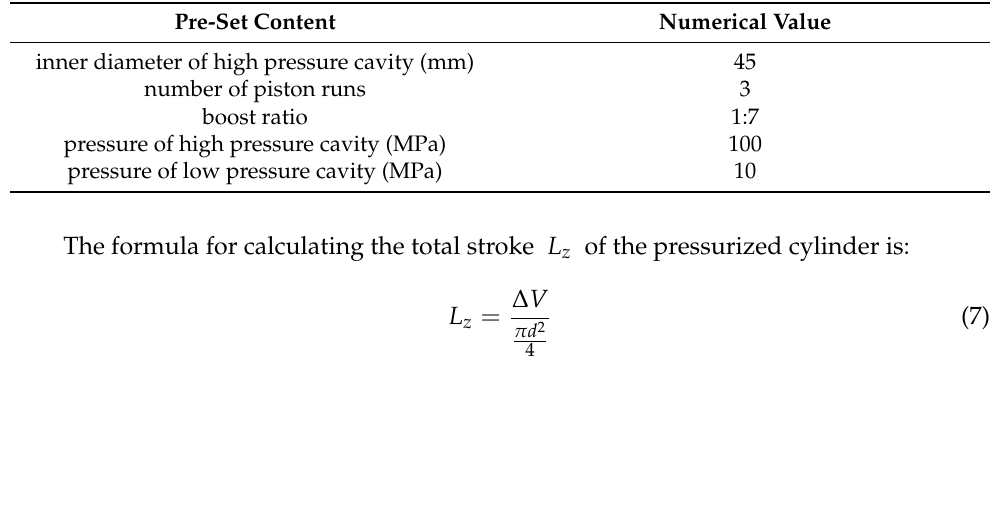
Table 2. Pre-set parameters of the pressurized